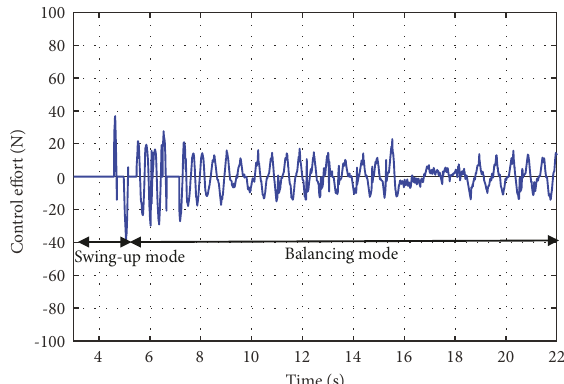
Figure 18: Cart position based on the suggested fuzzy-PID controller.